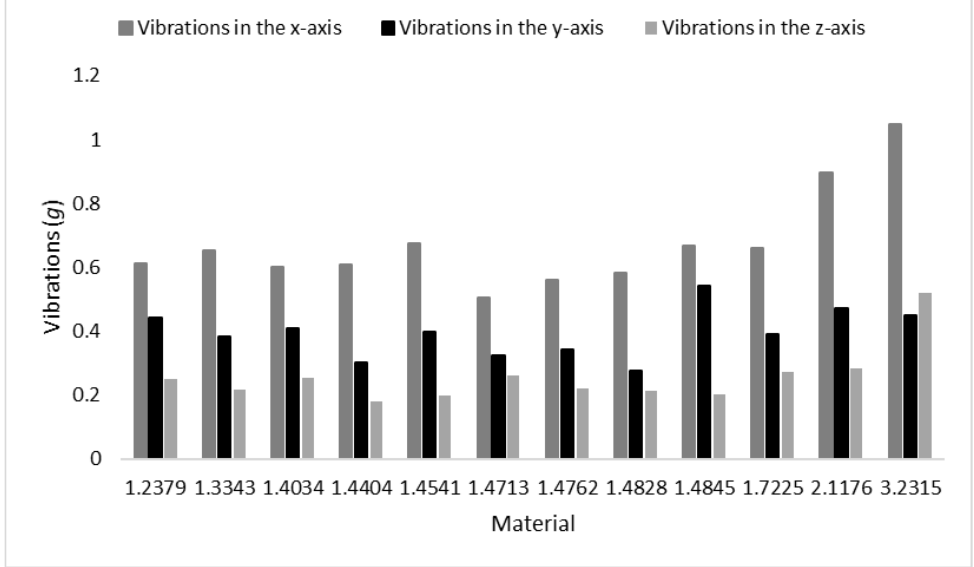
Figure 11. Vibrations in relation to the material type using the speed C.